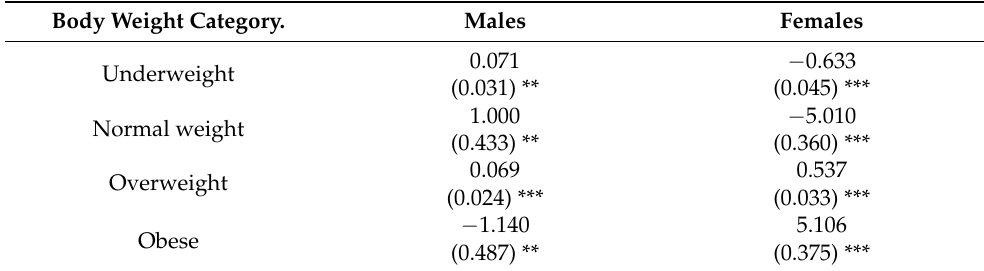
Table 2. Average treatment effects of depression on the probabilities of body weight categories for males and females. Body Weight Category.